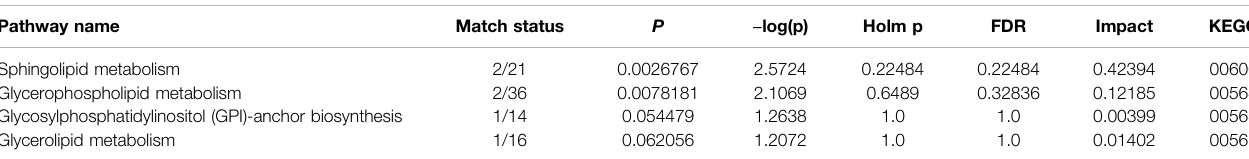
TABLE 3 | Ingenuity pathway analysis with MetPA from differential lipid